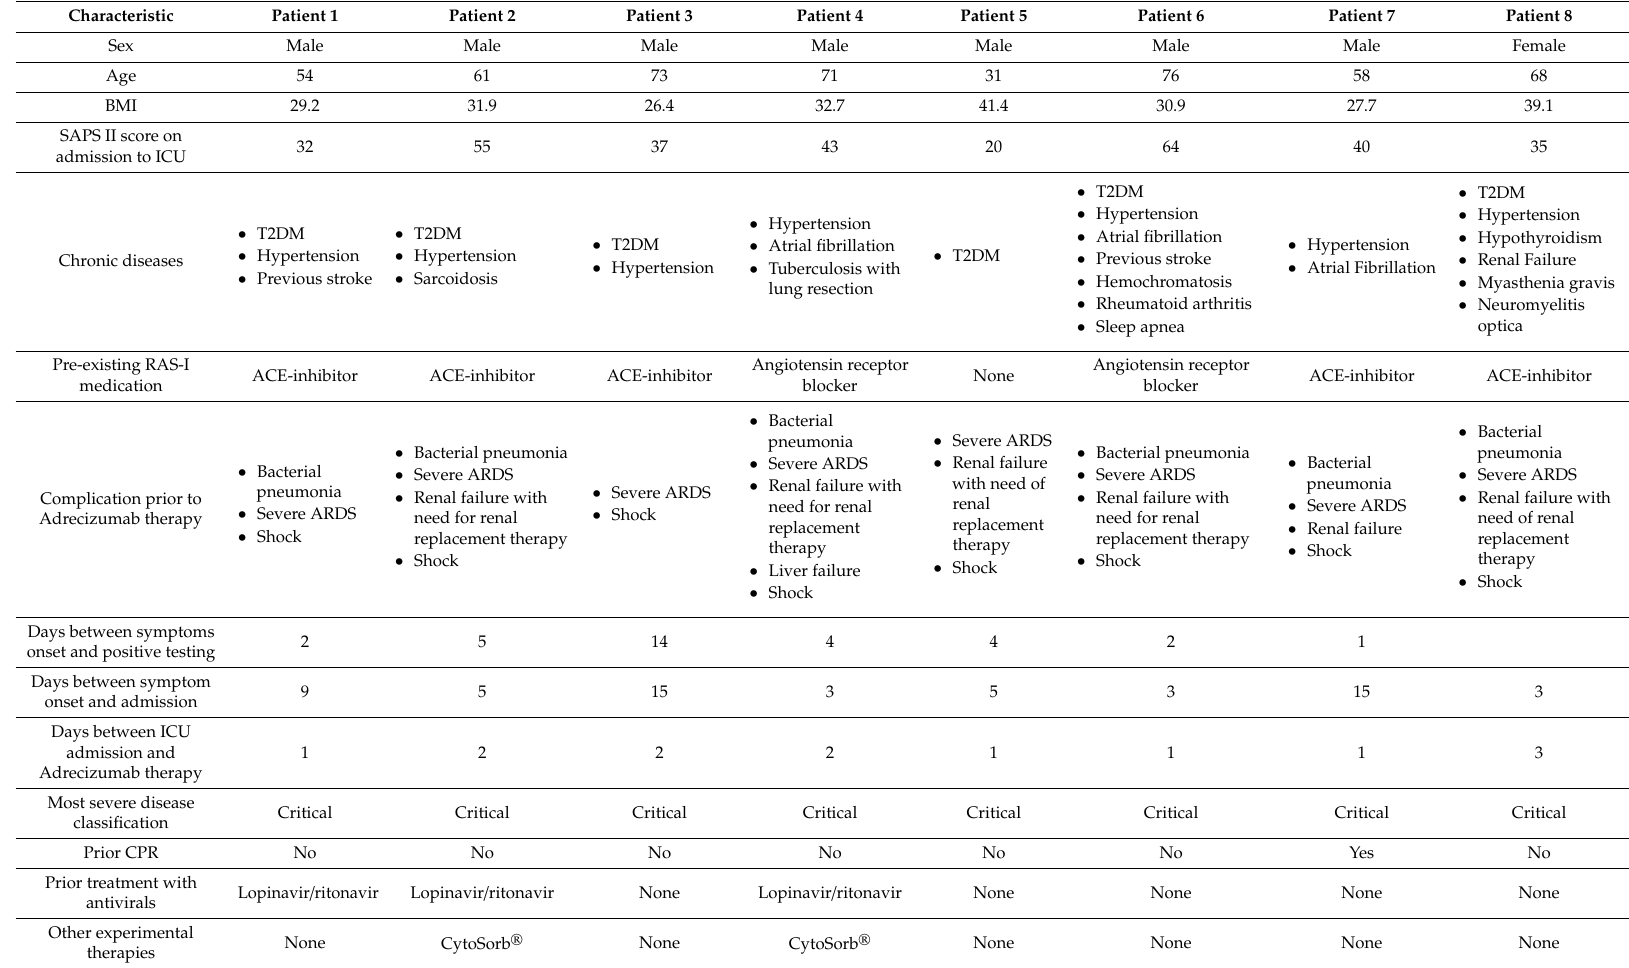
Table 1. Clinical characteristics of the 8 treated